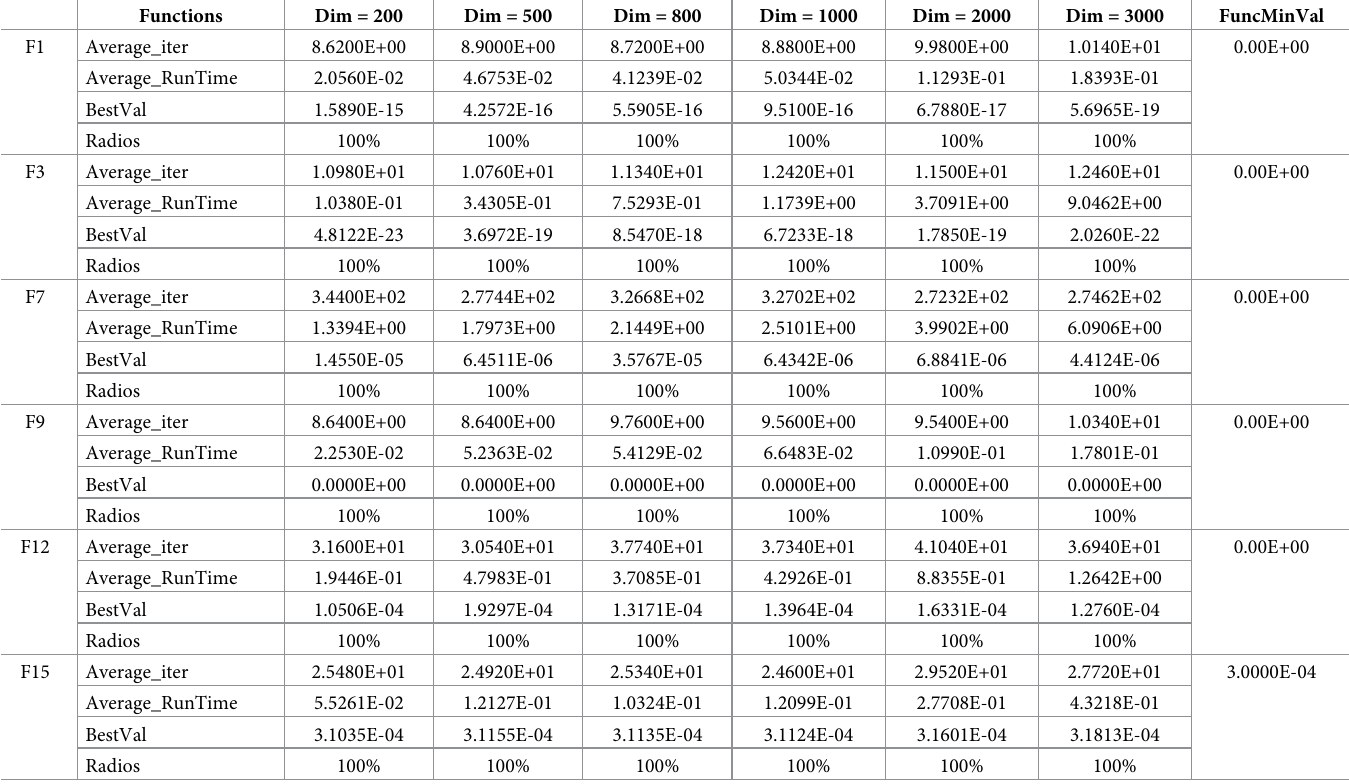
Table 6. High-dimensional function test results (50